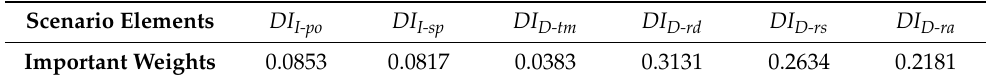
Table 7. The importance weights of the scenario elements.